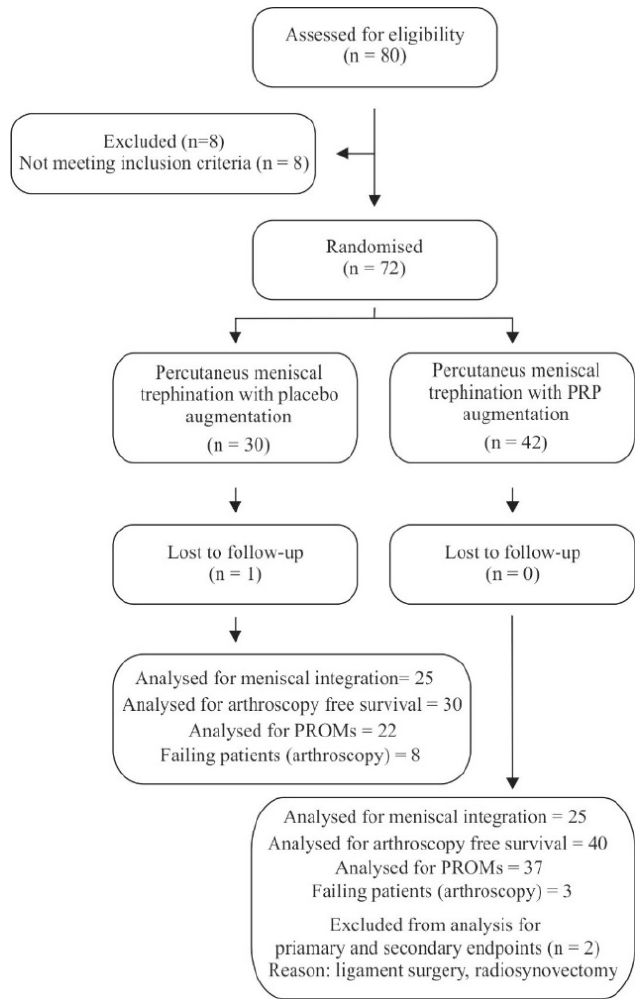
Figure 1. Flow diagram of the trial.